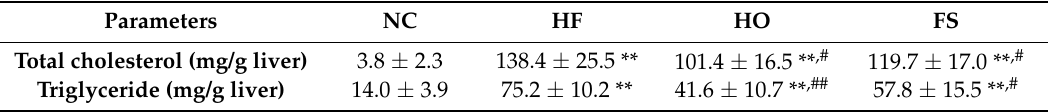
Table 5. The changes of triglyceride and total cholesterol levels in the livers of HF-diet-fed rats supplemented with or without orlistat and RMD for 8 weeks.